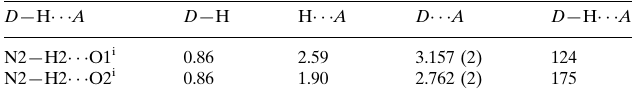
Hydrogen-bond geometry (A˚ , (cid:3)